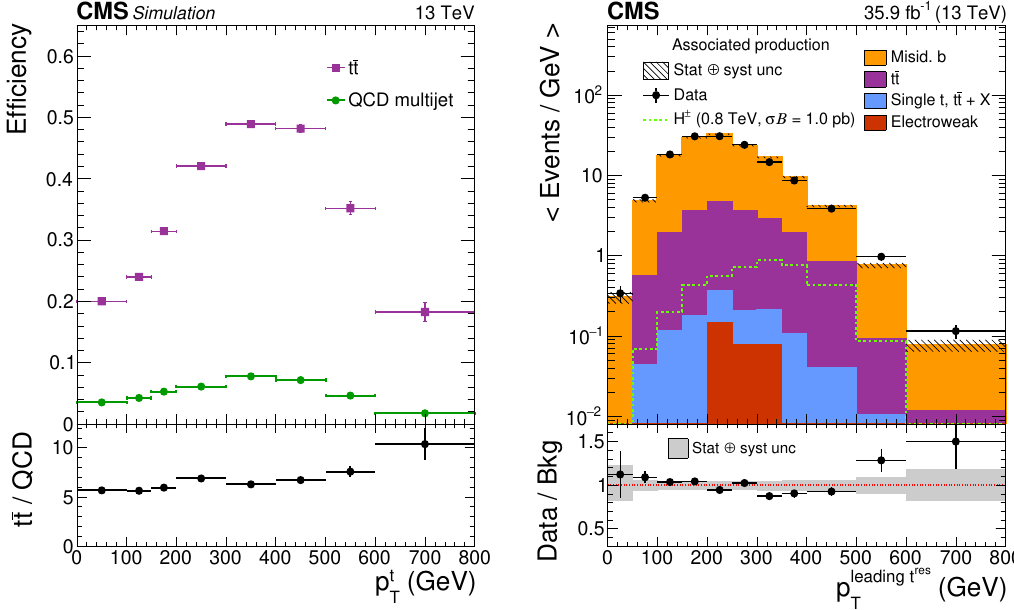
Figure 3 . The e(cid:14)ciency of the t res selection in simulated tt pairs and the misidenti(cid:12)cation rate for QCD multijet background, as a function of top quark or top quark candidate p (left). The p distribution of the leading t res (right) for the signal model and background with T normalization (cid:12)xed to the SM expectation. The dominant background containing misidenti(cid:12)ed b jets is primarily composed of QCD multijet processes and is estimated using a data-driven